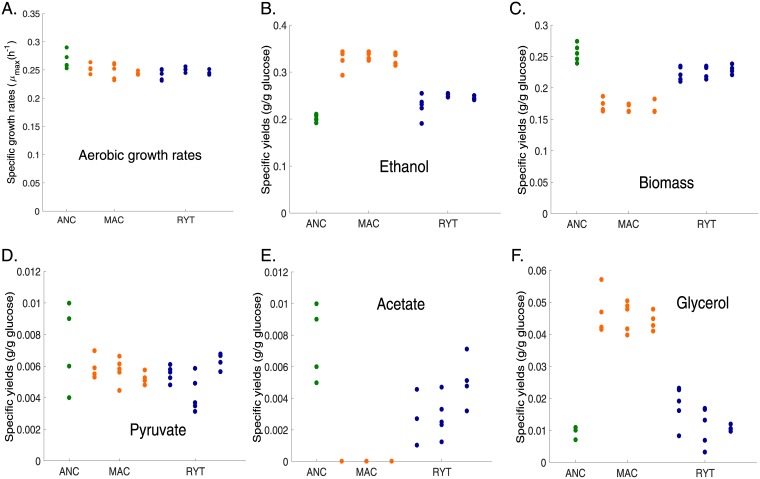
MAC and RYT differences are specific to aerobic conditions.Fermentation parameters of the ancestor (green), RYT (blue) and MAC (orange) strains are shown for strictly aerobic condition. Growth rates calculated for ancestral, RYT and MAC strains in strictly aerobic conditions (Mann-Whitney U, p < 0.05). (A). Specific product yields of the ancestor, MAC and RYT for ethanol (B), biomass (C), pyruvate (D), acetate (E), and glycerol (F) in strictly aerobic conditions. All the observed differences are significant (Mann-Whitney U, p < 0.05).